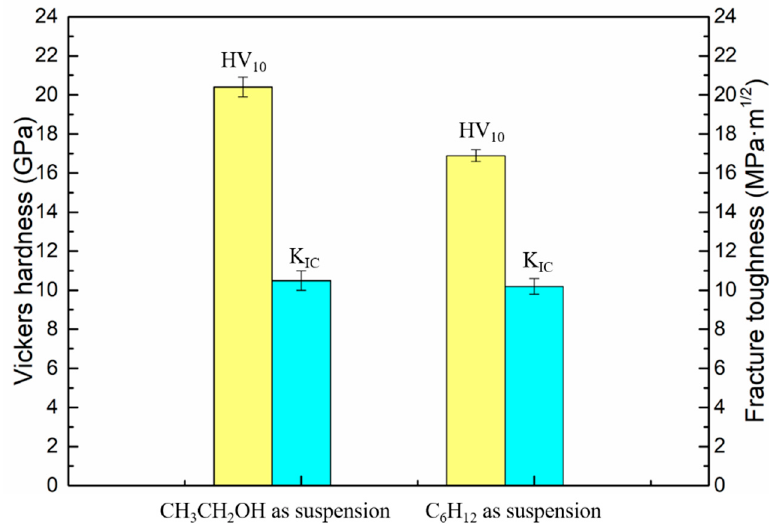
Figure 9. Hardness and fracture toughness of the sintered WC-10Ni 3 Al composites using di ff erent ball-milling suspensions.